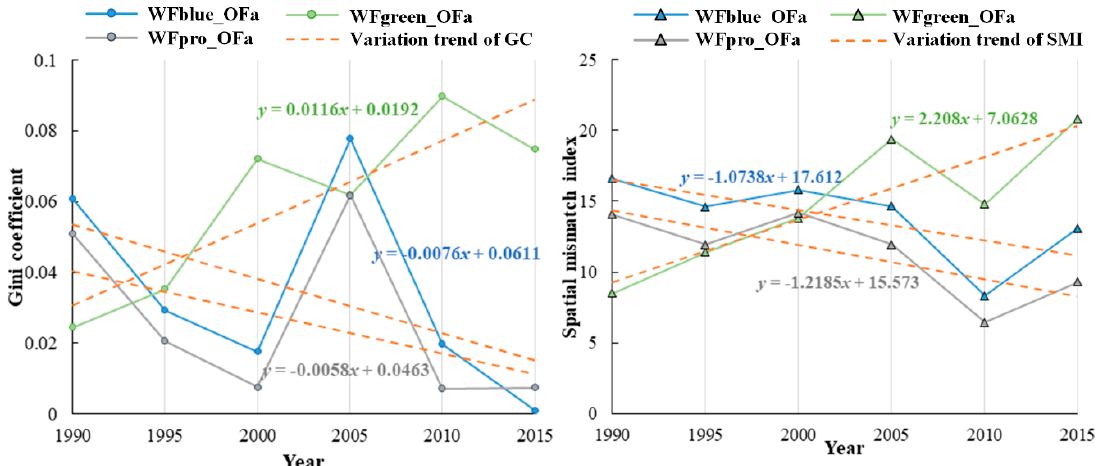
Figure 4. The Gini Coefficient and spatial mismatch index of crop water footprint and oasis farmland .